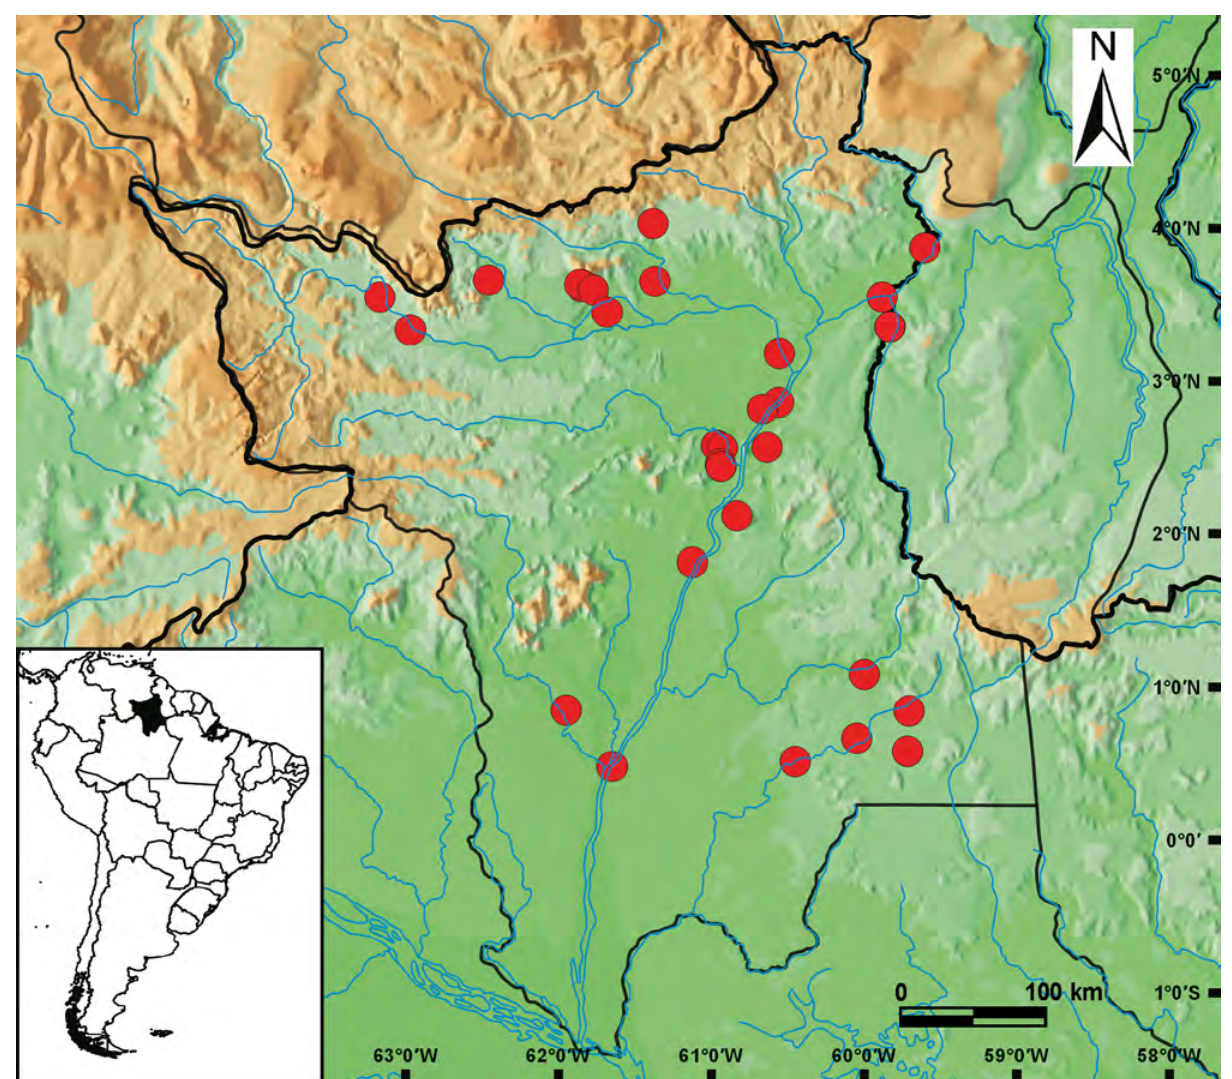
Figure 6. Distribution of the trichodactylid species, Sylviocarcinus pictus (H. Milne Edwards, 1853), in the state of Roraima, Brazil. Parima basin (trib. of rio Uraricoera), rio Kanaakiú, PIN Xitei/Xidea, 02°36’29”N 063°52’18”W, 780